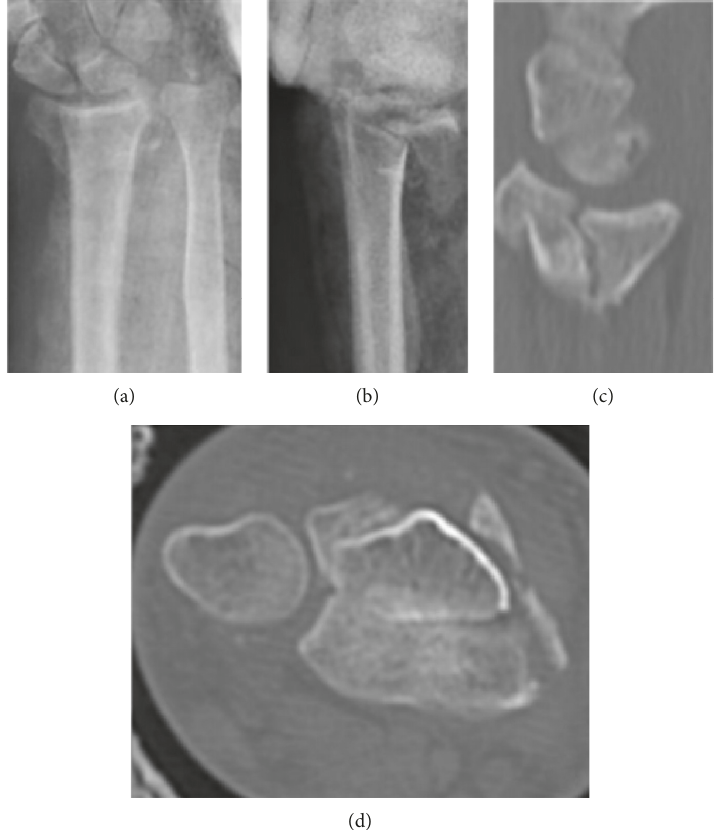
Figure 1: Preoperative X-rays, anteroposterior and lateral view of the 23C2 fracture (a, b). CT scan showing articular damage (c,